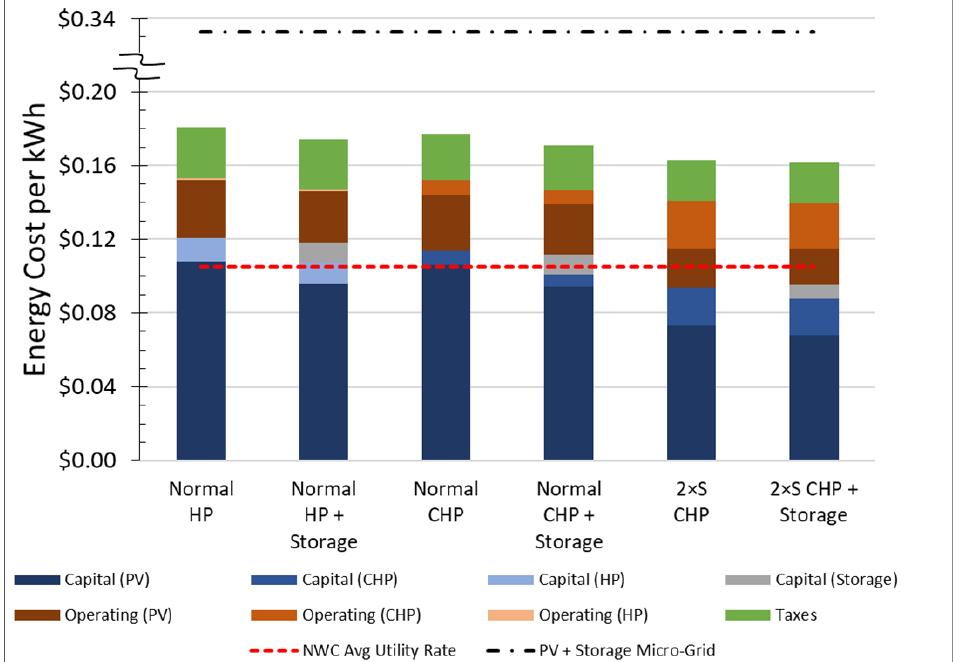
Figure 9. Net-zero energy Levelized Cost of Energy (LCOE) breakdown and comparison. CHP scenarios result in lower LCOE due to better winter (December, January, February) load matching and lower per energy generation capital cost. The 2 × Summer (2 × S) CHP is the lowest LCOE benefiting from better summer (June, July, August) load/generation matching. The impact of storage is minimal with the buy:sell ratio of 3 assumed in the analysis. The best net-zero energy LCOE is just above 0.16 $/kWh, which is considerably higher than the average retail electricity rate paid by NWC (0.11 $/kWh), but much lower than the PV + storage micro-grid (0.33 $/kWh), both of which are included on the plot for comparison.